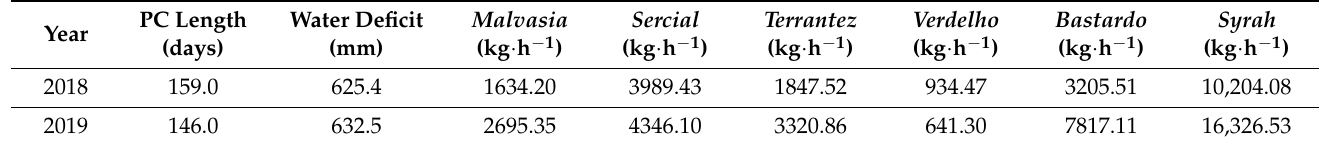
Table 11. Major grapevine verities production in QV was registered during 2018 and 2019. The table shows the Production Cycle length (PC, days), estimated water deficit, in mm, calculated by the difference between theoretical estimated crop needs and observed precipitation and varieties production in kg per hectare (kg · h − 1